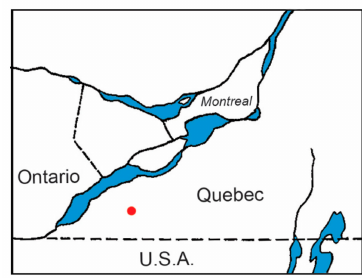
Figure 1. Map shows the songbird monitoring site at Mont é e Biggar, Qu é bec. The red dot indicates the location of an established population of blacklegged ticks and associated Lyme disease endemic